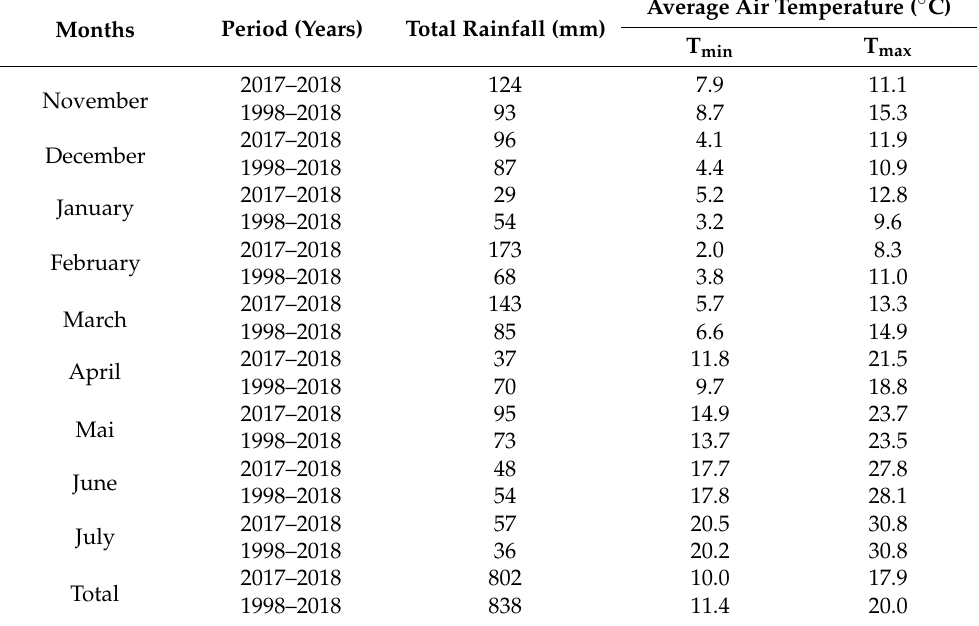
Table 1. Thermo-pluviometric trends observed in the experimental site during the experimental period (November 2017–July 2018) and in a long-term period (1998–2018). Rainfall (mm) is re- ported monthly and in total for the whole period, and minimum (T min ) and maximum (T max ) air temperatures are shown monthly and for the whole